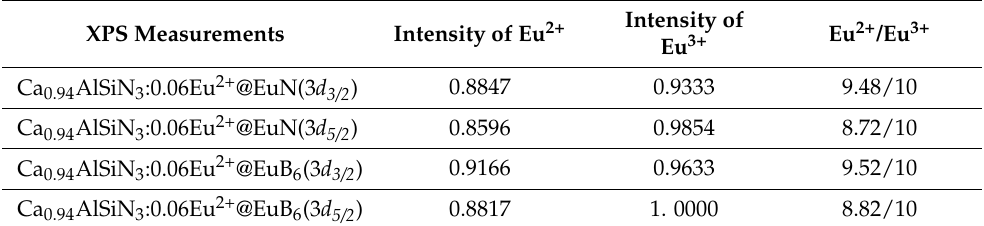
Figure 4. The XPS spectra of Eu 3 d in Ca 0.94 AlSiN 3 :0.06Eu 2+ @Eu 2 O 3 (black line), Ca 0.94 AlSiN 3 : 0.06Eu 2+ @EuN (blue line) and Ca 0.94 AlSiN 3 : 0.06 Eu 2+ @EuB 6 (red line). Table 2. Intensity ratios of Eu 2+ /Eu 3+ in Ca 0.94 AlSiN 3 :0.06Eu 2+ @Eu 2 O 3 , Ca 0.94 AlSiN 3 :0.06Eu 2+ @EuN and Ca 0.94 AlSiN 3 :0.06Eu 2+ @EuB 6